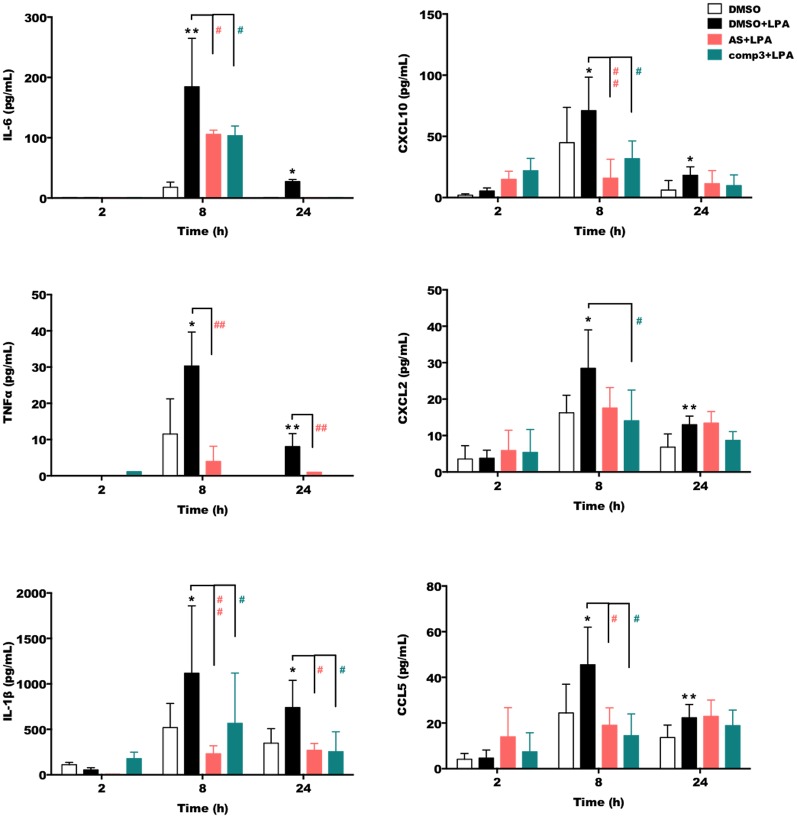
AS2717638 and compound 3 reduce LPA-mediated secretion of pro-inflammatory cytokines and chemokines. BV-2 microglia were cultured on 24-well plates and serum-starved o/n. The supernatants were collected after incubation with vehicle control (DMSO), DMSO plus LPA (1 μM) or LPA plus AS2717638 (0.1 μM) or compound 3 (1 μM) for 2, 8, and 24 h. ELISA was used to quantify the concentrations of IL-6, TNFα, IL-1β, CXCL10 (IP-10), CXCL2 (MIP-2), and CCL5 (RANTES). Results shown represent mean ± SD from three independent experiments performed in triplicate (*p < 0.05; **p < 0.01 compared to vehicle control; #p < 0.05, ##p < 0.01; each inhibitor compared to LPA-treated cells; one-way ANOVA with Bonferroni correction). No bars = below detection limit.